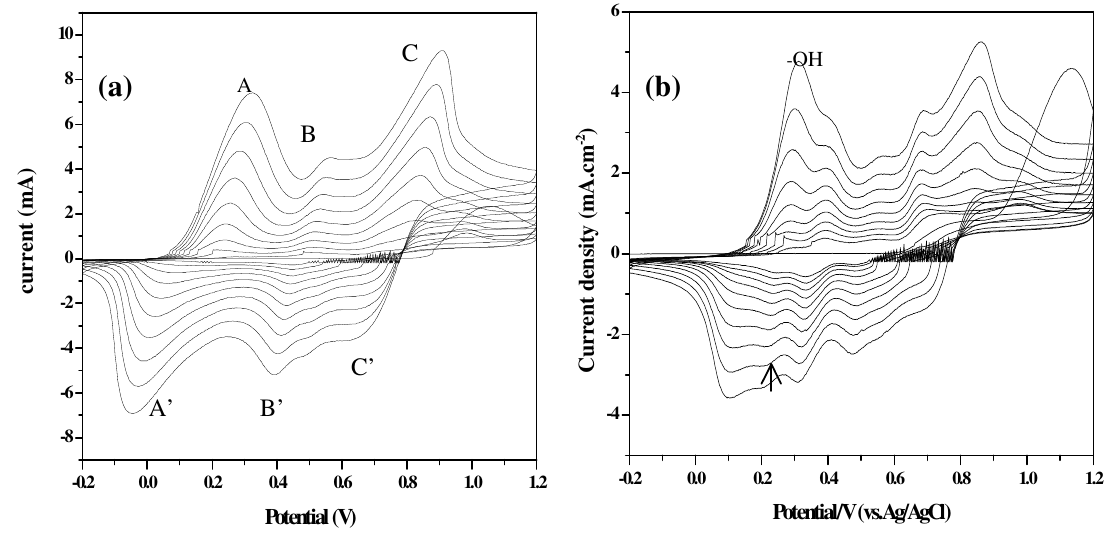
Figure 1. Cyclic voltammograms recorded during polymerization of 0.1 M aniline (a) and 0.1 M aniline with 2.5 mM m -aminophenol (b) on Au electrode in 0.5 M